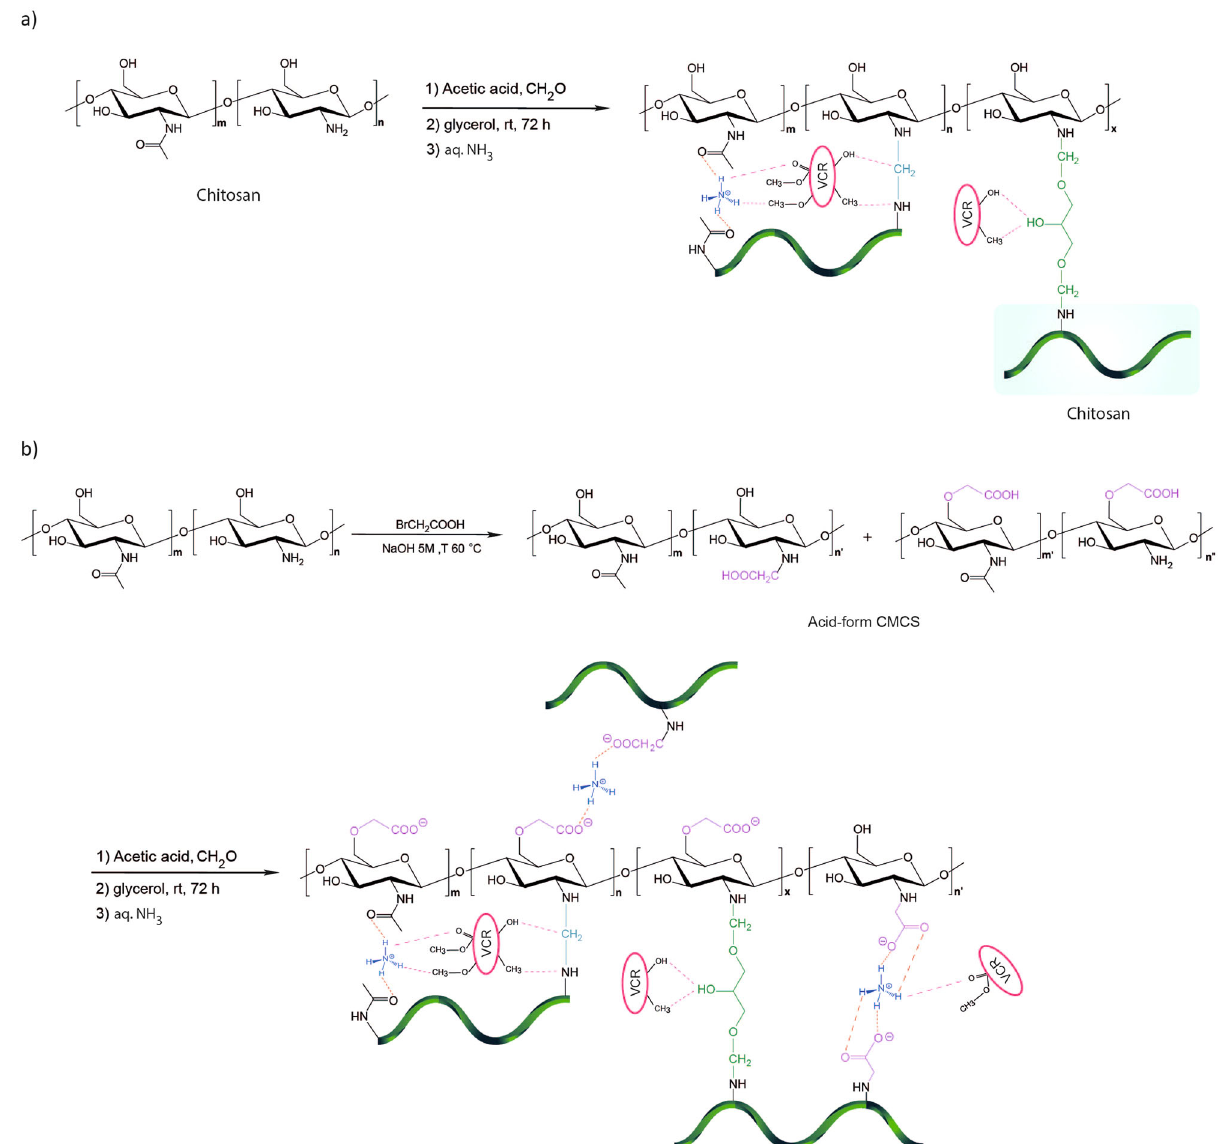
Fig. 1 Synthesis pathway of hydrogels. a CS-g-gly, ( b )